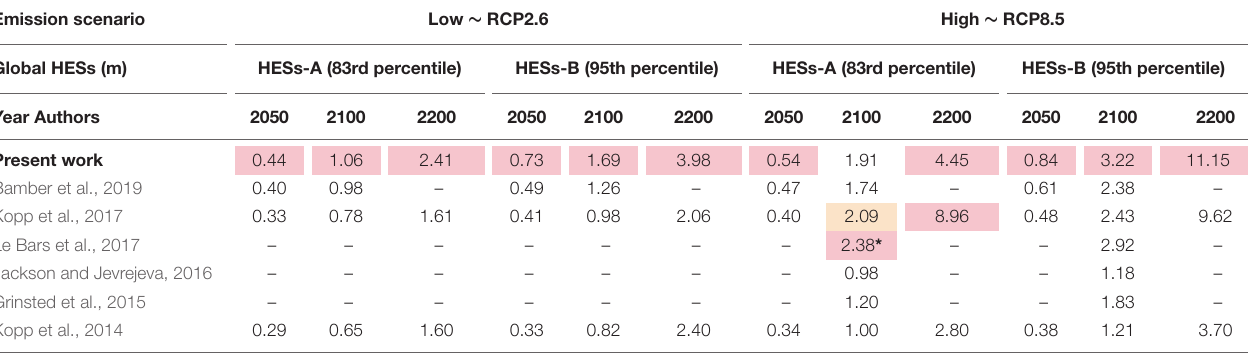
TABLE 2 | Global HESs (m) as provided in selected recent publications and in the present work. Emission scenario